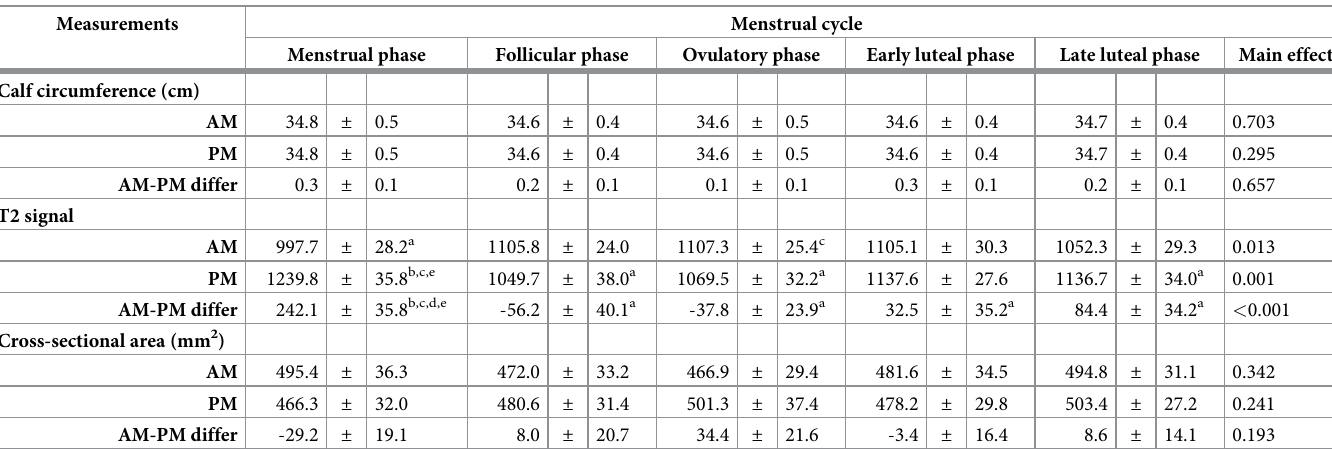
Table 2. Assessment of fluid retention in the calf.